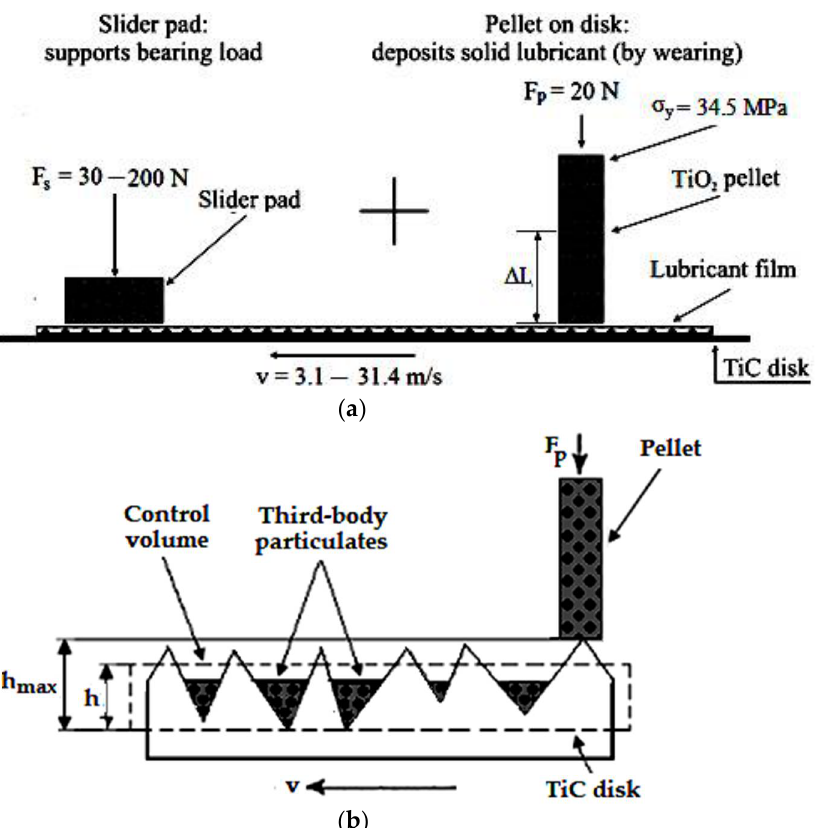
Figure 2. Schematic setup of the pellet/disk in line with a slider pad/disk for the transferred powder film study with self-replenishing and self-repairing ( a ) and of the pellet sheared intentionally against the TiC disk ( b ).